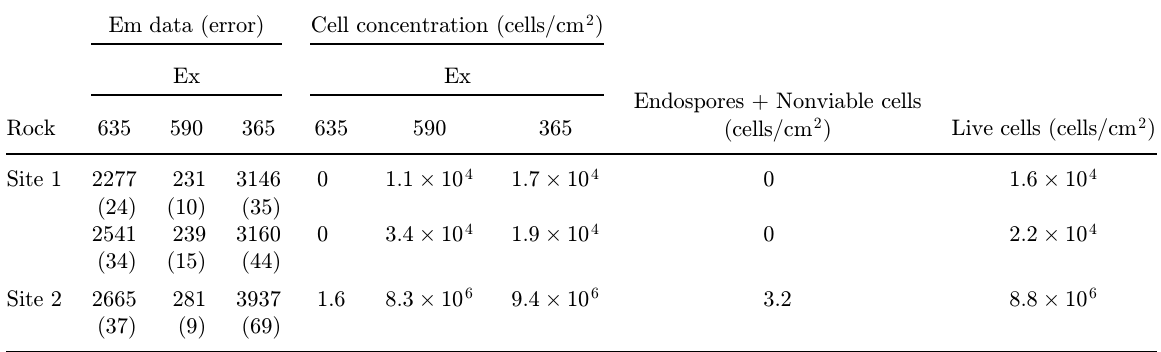
Table 2. Palander rock surface °uorescence measurements a and derived cell